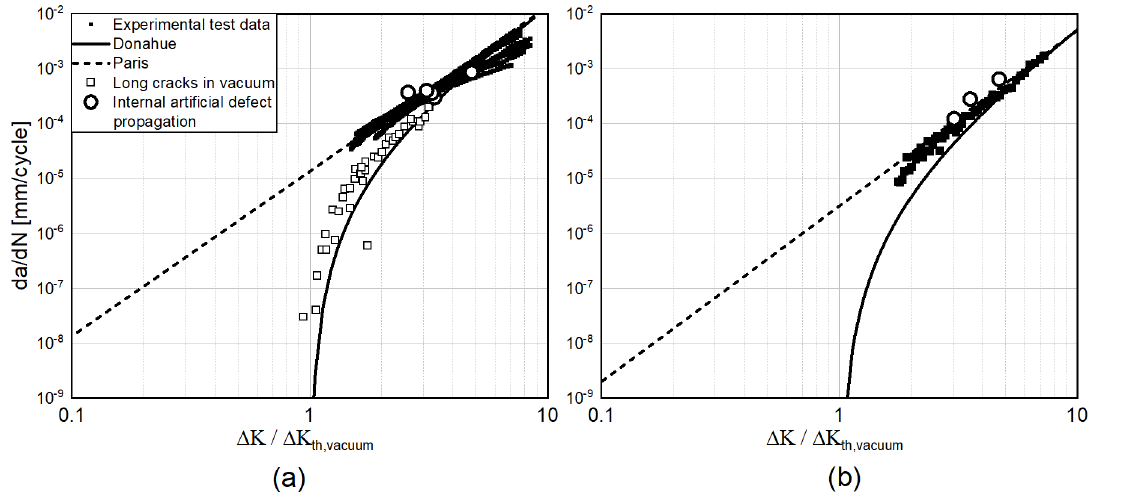
Figure 14. Fatigue crack growth data for ( a ) Ti6Al4V and ( b ) Inconel 718. The ∆ K th values identified for the two materials through the Kitagawa diagram are, respectively, highlighted in the two graphs. The Titanium propagation data in vacuum were taken from